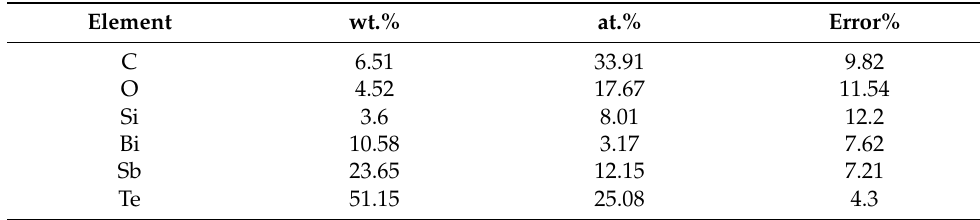
Table 1. The element amount in the (Bi 0.48 Sb 1.52 )Te 3 thick film. Element